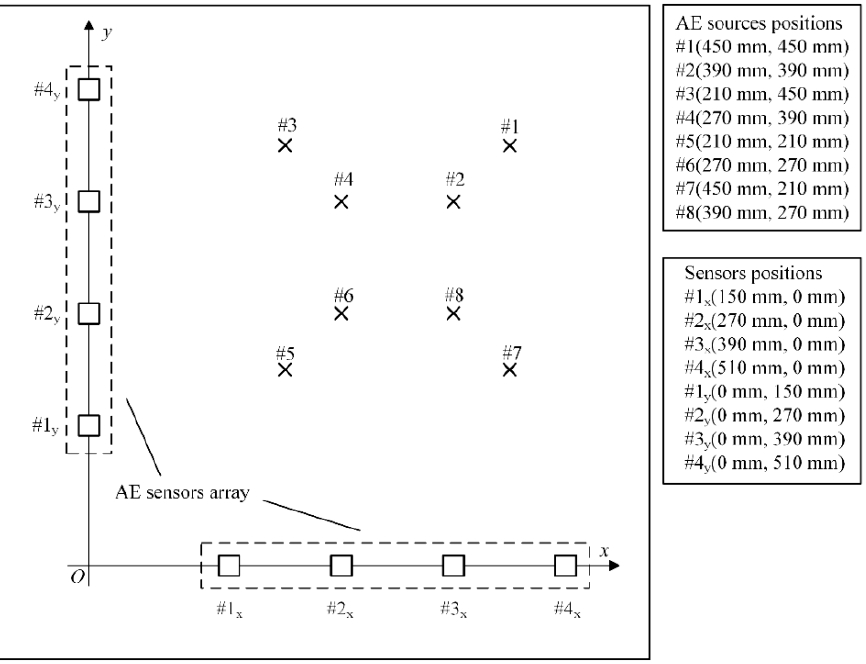
Figure 9. The arrangement of sensors and AE sources in the pencil-lead break (PLB) test. Table 4. Localization results comparison by PLB